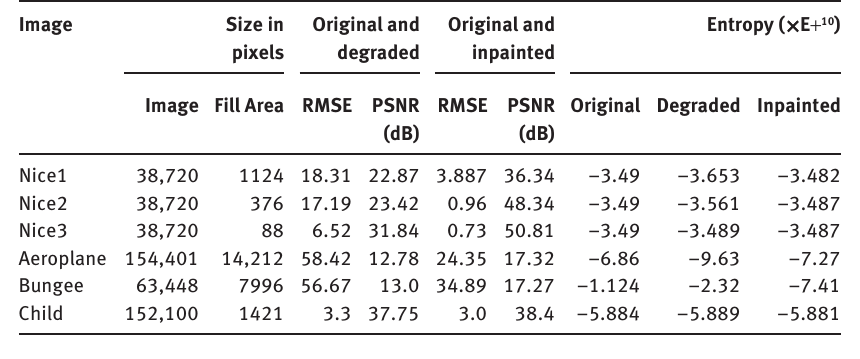
Figure 16. Curved Structure Reconstruction: Patch Size 9 × 9. Table 1. Comparative